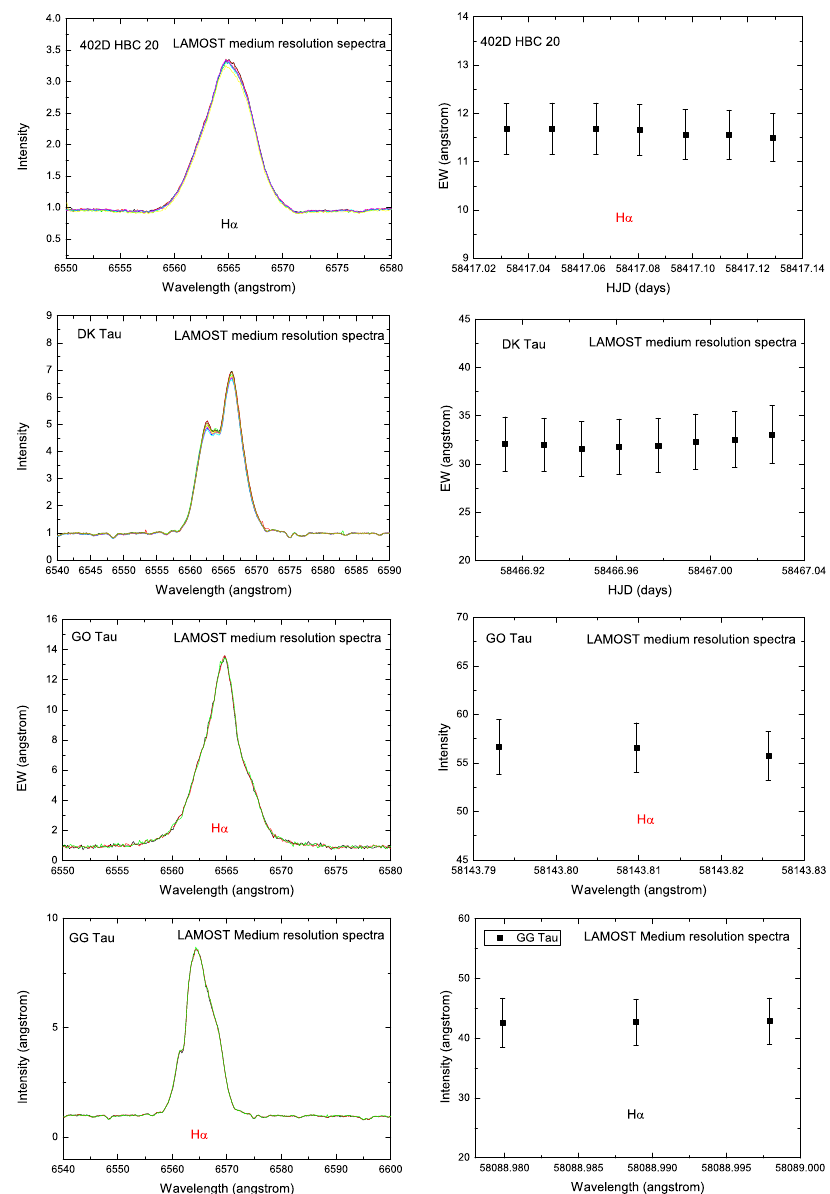
Figure 5. Examples of radio stars with stable H α emissions and